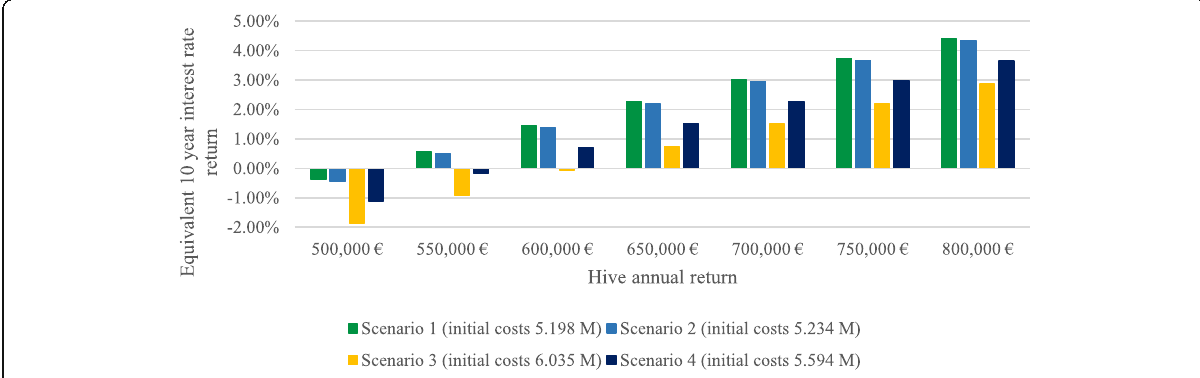
Fig. 9 comparison of equivalent 10-year return rates on investment as a function of various hive annual economic return thresholds across the four considered